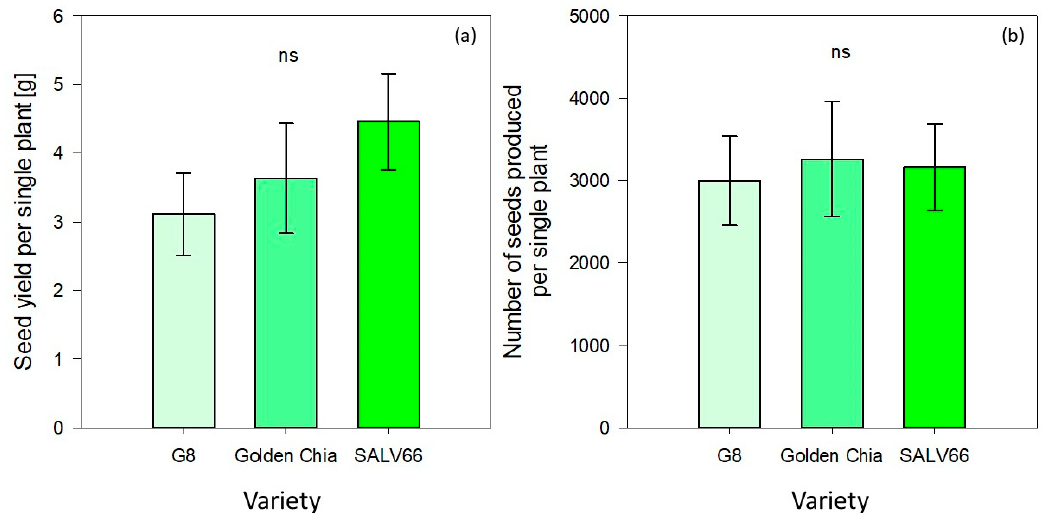
Figure 3. Seed yield (g per plant) ( a ) and number of seeds produced per single plant ( b ) of three chia varieties (G8, Golden Chia, SALV66) cultivated and manually harvested at Ihinger Hof in 2018. Means which share a common lowercase letter are not significant at α = 0.05. ( n = 3, α = 0.05, means ± standard error bars based on model [2]).